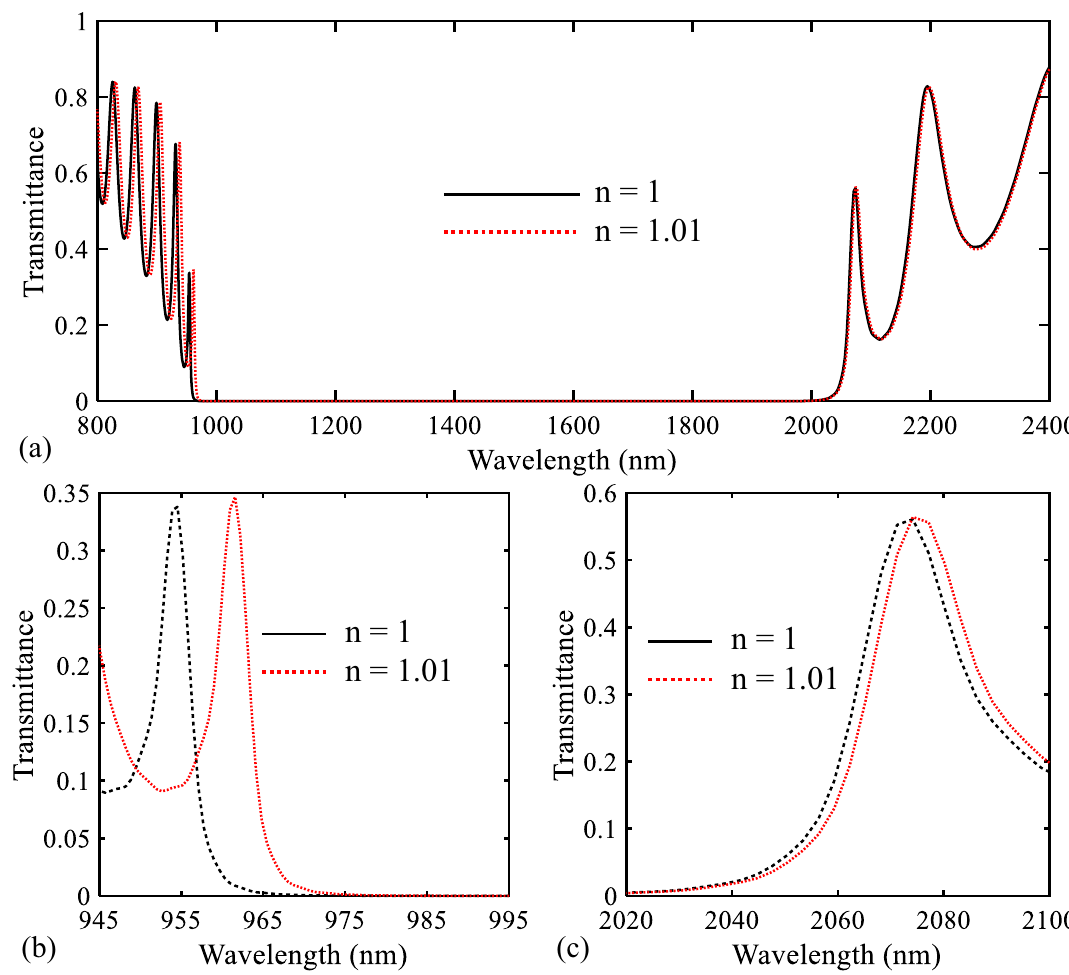
Figure 7. Transmission spectra of the proposed biosensor I for n = 1 and n = 1.01 in different wavelength ranges.